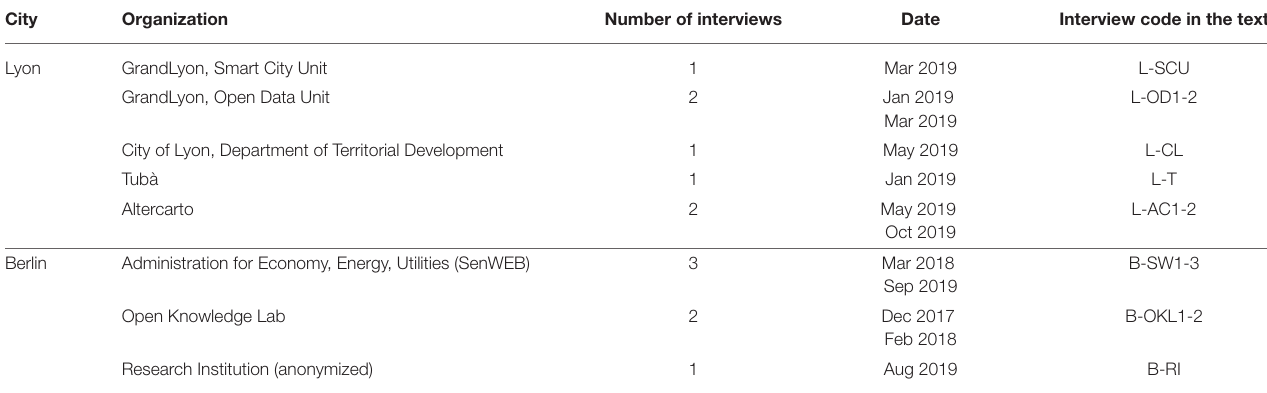
TABLE 2 | List of Interviews conducted (section Research